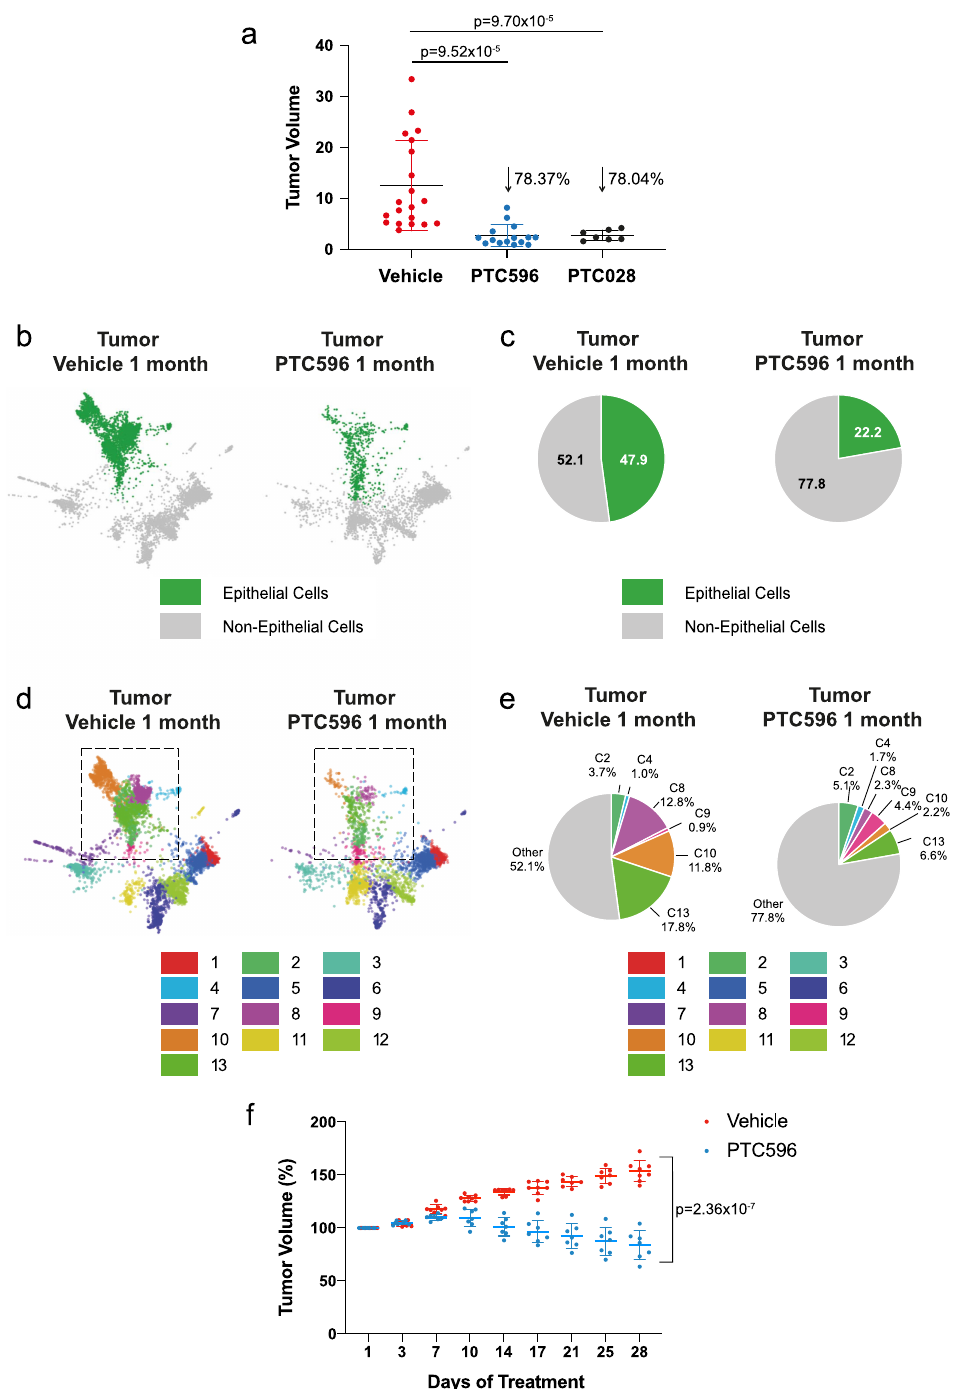
Fig. 7 PTC596 in vivo treatment affects the growth of KRAS- mutant ADCs. a A549 xenografts tumor volumes at treatment termination (vehicle n = 20, red; PTC596 n = 15, blue; PTC208 n = 7, black) normalized to the tumor volume measured at the beginning of treatment. The difference in tumor size at day 21 was statistically signi fi cant ( p values are indicated). b SPRING plots showing epithelial compartments (green) in vehicle- ( n = 3, left panels) versus PTC596-treated tumors ( n = 2, right panels). c Pie charts summarizing the epithelial cell proportions in vehicle- (left panels) and PTC596-treated tumors (right panels). d SPRING plots of the 13 clusters in vehicle- (left panel) and PTC596- (right panel) treated tumor samples. e Pie charts summarizing epithelial sub-cluster compositions in vehicle- (left panels) and PTC596- (right panels) treated tumors. f The graph shows the percentage of change in tumor volume measured by MRI at the indicated time points, between PTC596 ( n = 7, blue) and vehicle-treated ( n = 8, red) groups. Error bars represent SD. P value is